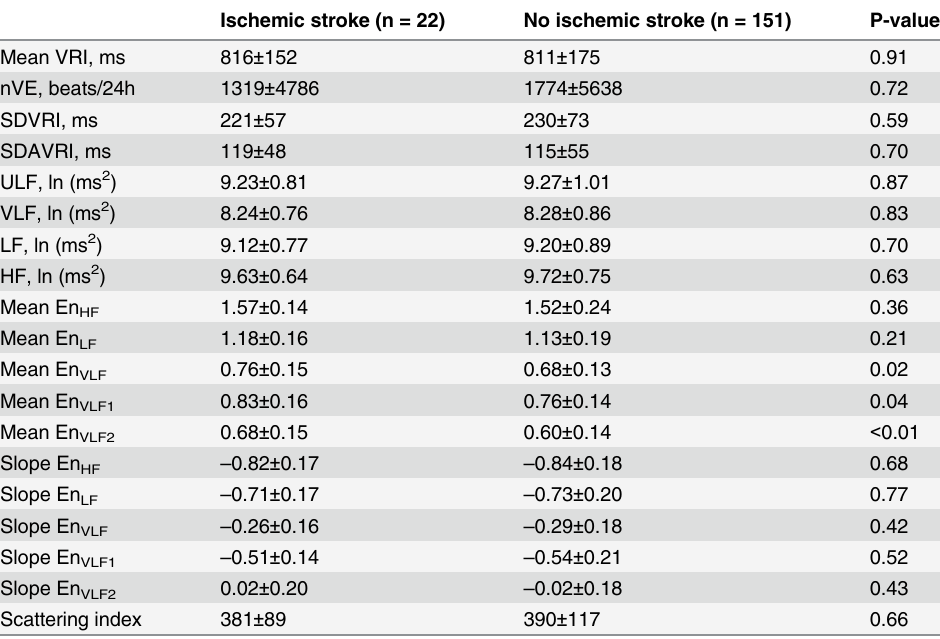
Table 2. Holter ECG analysis and heart rate variability measurements.